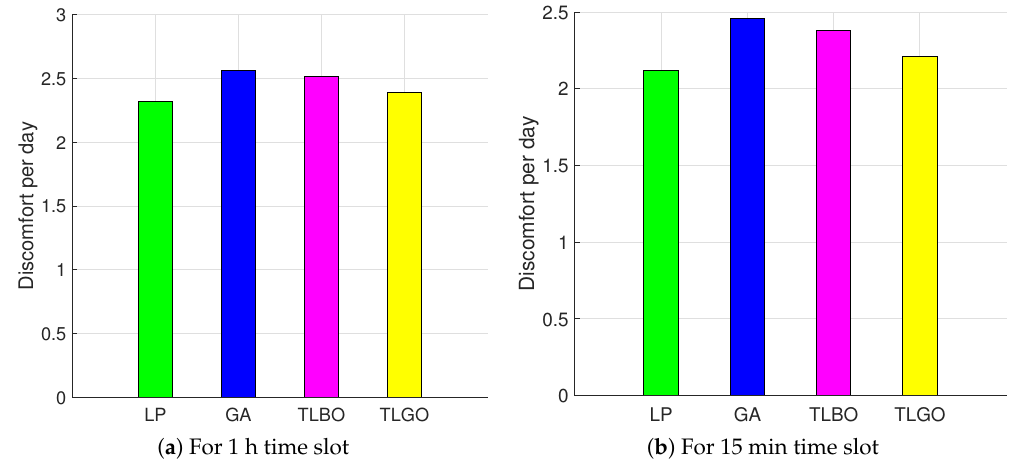
Figure 10. Discomfort under CPP.